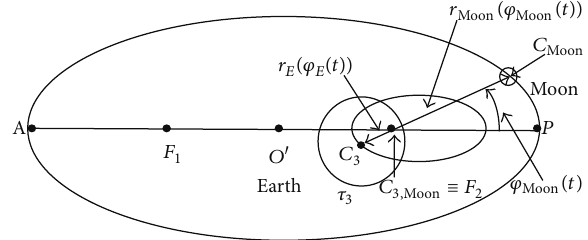
Figure 9: The geometric sketch of circulation of the mass center 𝐶 3 of the Earth 𝜏 3 and the mass center 𝐶 of the Moon around the MOON of the Earth-Moon system. combined mass center 𝐶 3, MOON